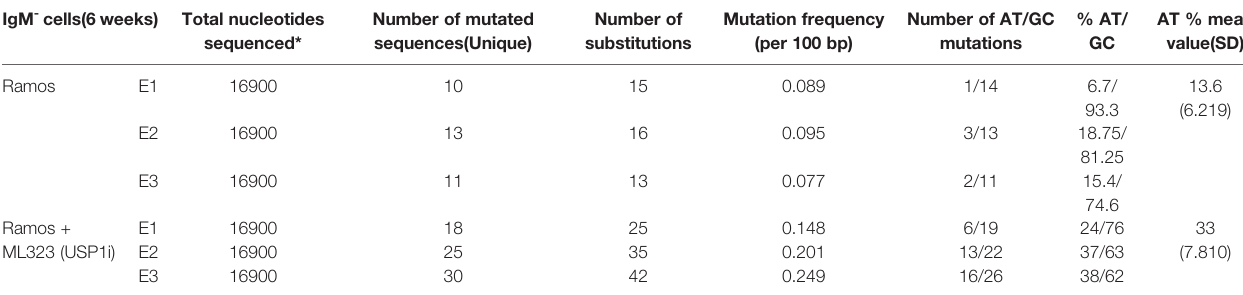
TABLE 1 | Somatic mutations in VH4 sequence (338 bp) from Ramos cell treated or not with USP1 inhibitor. IgM - cells(6 weeks) Total nucleotides